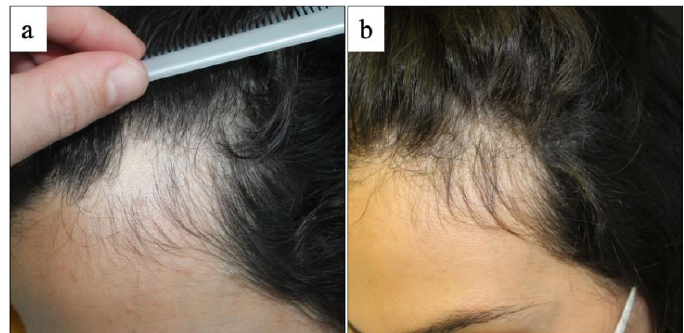
Figure 2. Clinical evaluation of alopecia areata at baseline and at 12 weeks of treatment: ( a ) presence of a well-defined oval patch of alopecia located on the left fronto-parietal region in a 42-year-old female with history of alopecia, exhibiting ( b ) hair regrowth after application of topical 0.05% clobetasol solution.